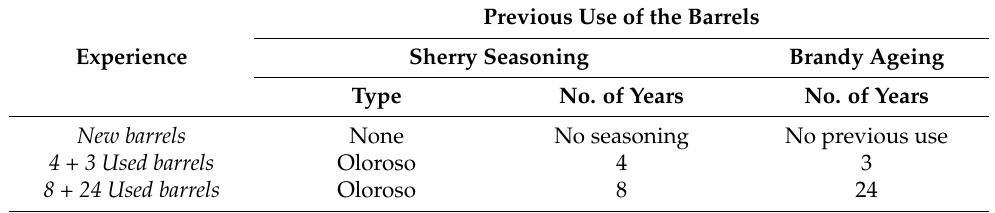
Table 1. Experimental conditions under study.